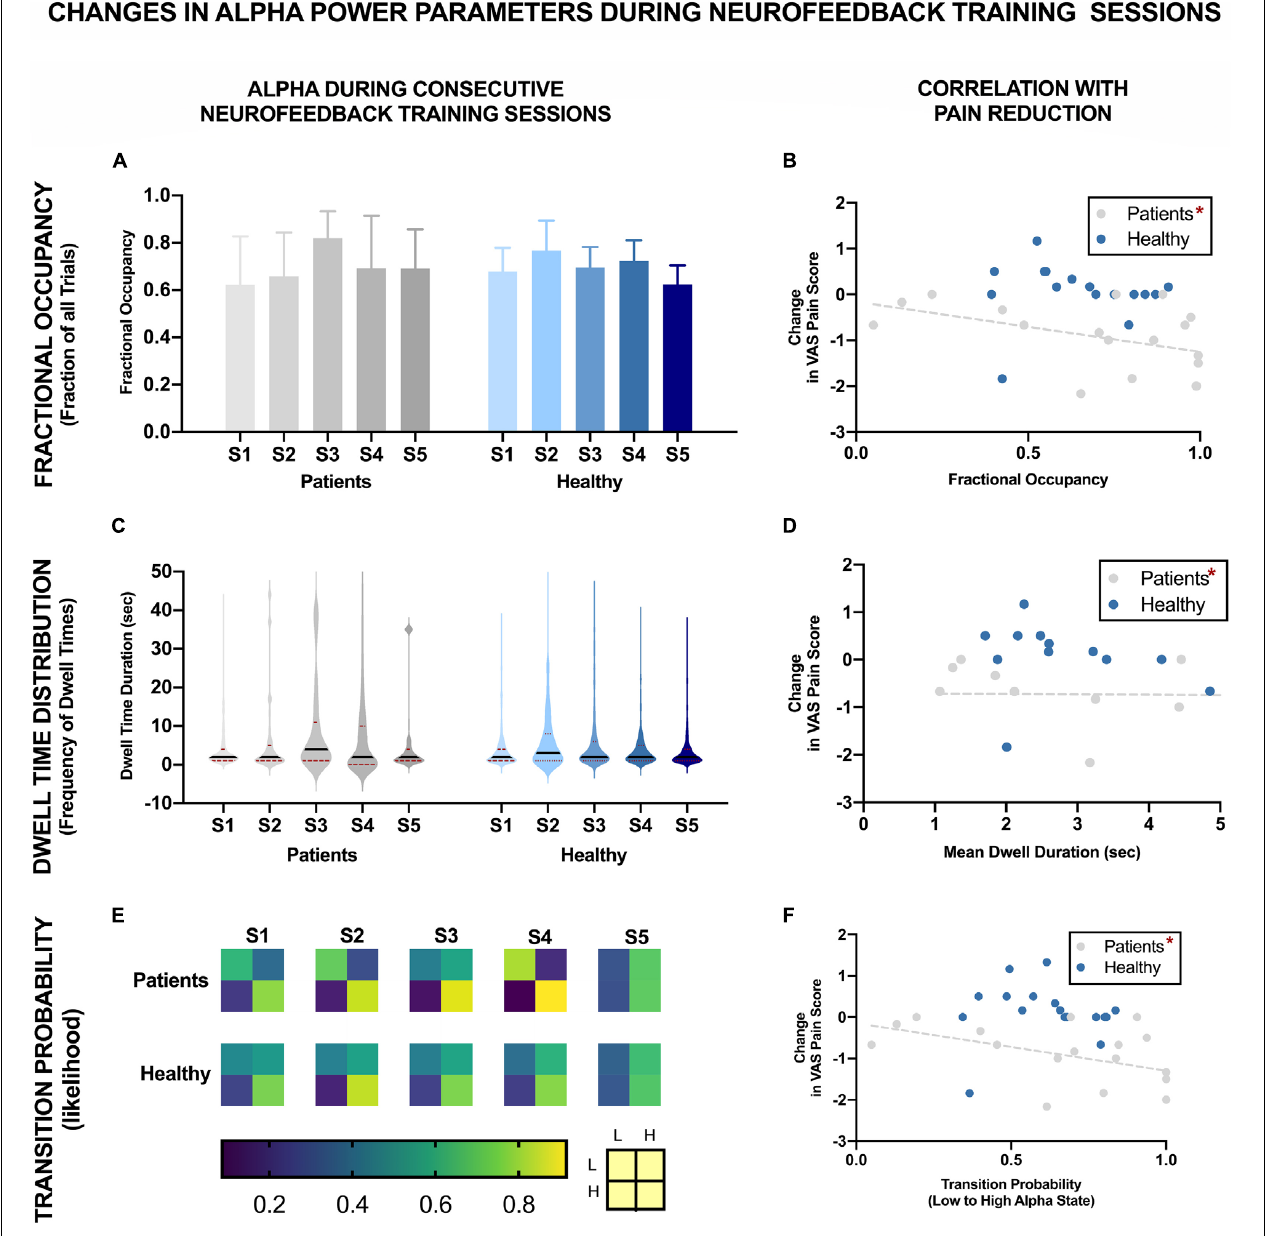
FIGURE 4 | EEG Brain alpha states characteristics over five NFB sessions in chronic pain patients and healthy participants and their correlation with reduction in VAS pain ratings. The NFB sessions are denoted by S1–S5. Error bars show standard error. L refers to low alpha state and H refers to high alpha state. *Statistically significance of p <